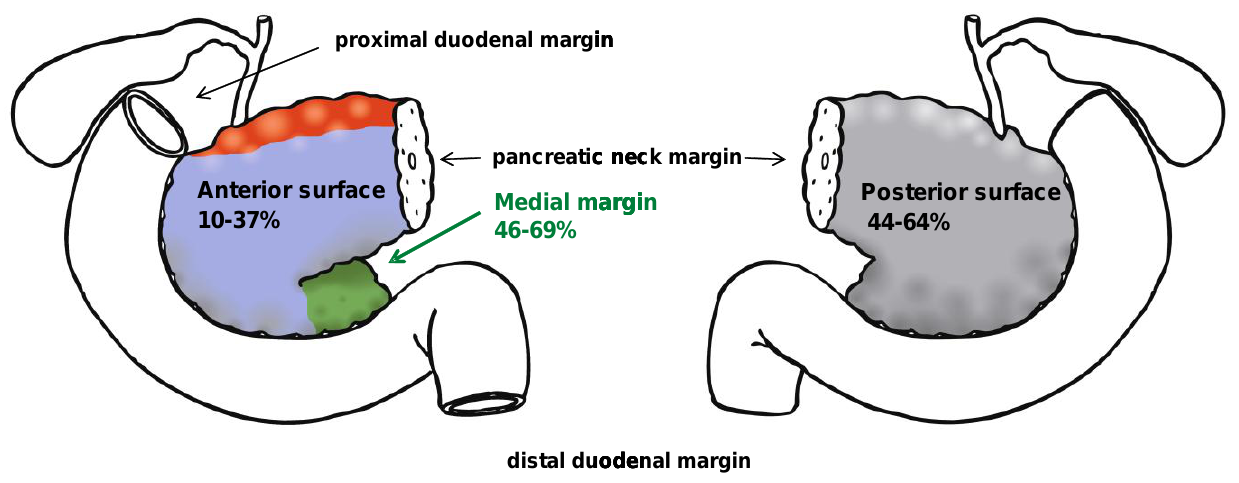
pancreatic neck margin